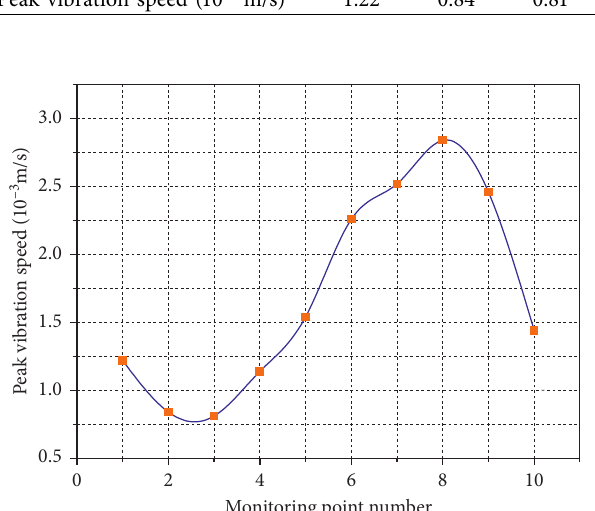
Figure 8: Distribution curve of the biggest vibration velocity of X direction of each point in